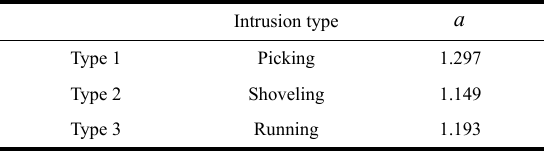
Table 1 Scaling